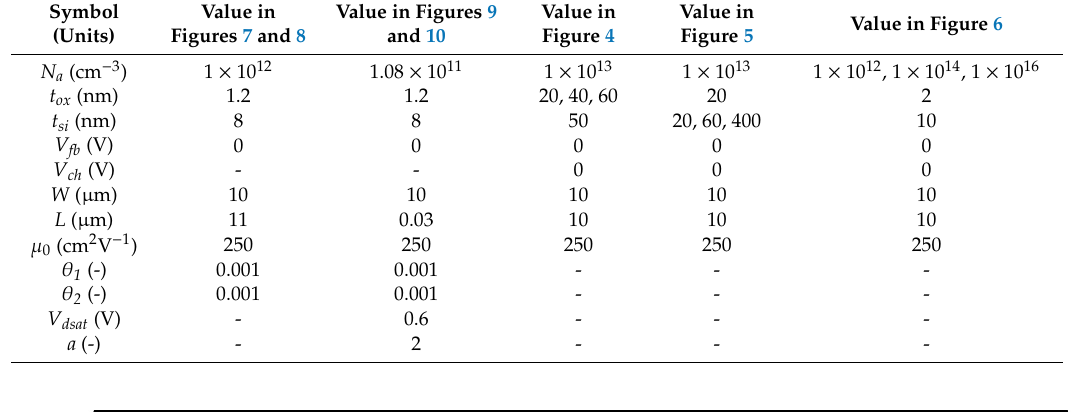
Table 1. Parameters for simulations in Figures 4–10.